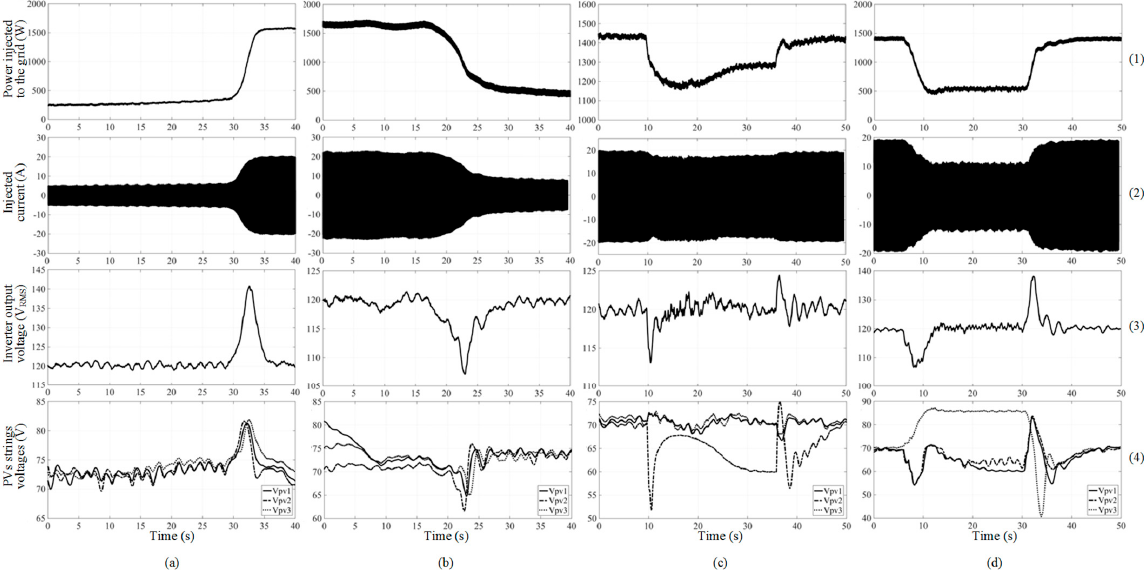
Figure 10. Evaluated scenarios: ( a ) with no PS and with transition from low irradiance (297 W/m 2 ) to high irradiance (1067 W/m 2 ); ( b ) with no PS and with transition from high irradiance (1250 W/m 2 ) to low irradiance (487 W/m 2 ); ( c ) high irradiance (1027 W/m 2 ) with PS of one PV set; ( d ) high irradiance (1027 W/m 2 ) with PS of two PV sets.